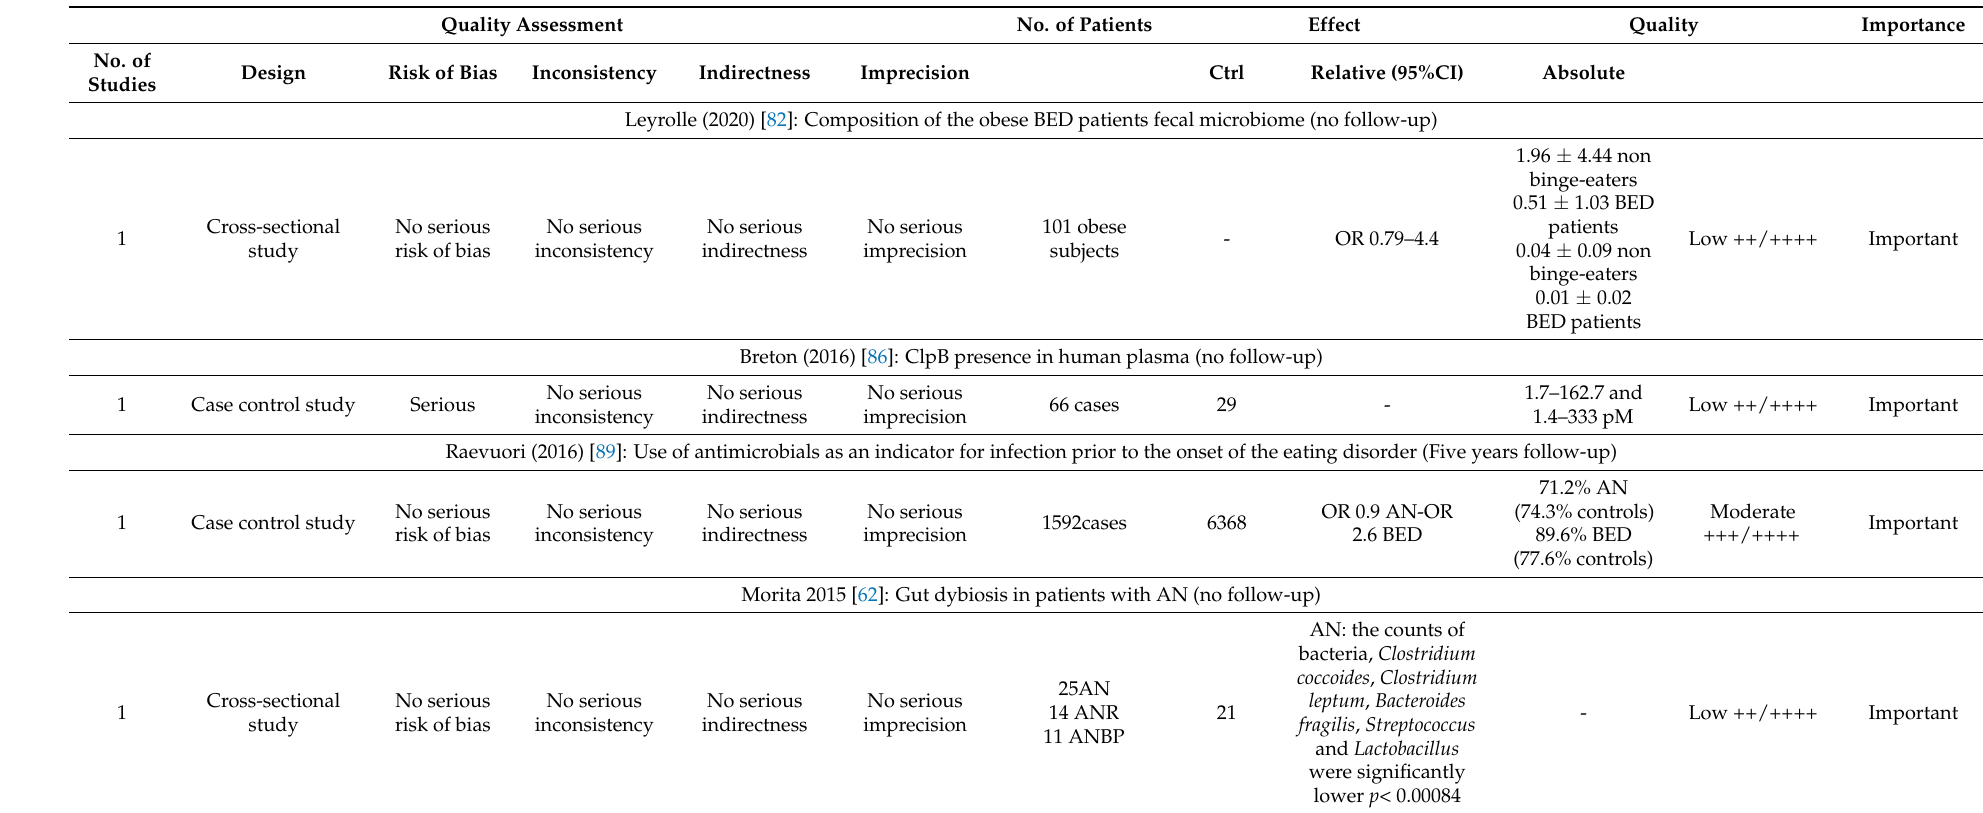
Table 4. Summary of GRADE evidence